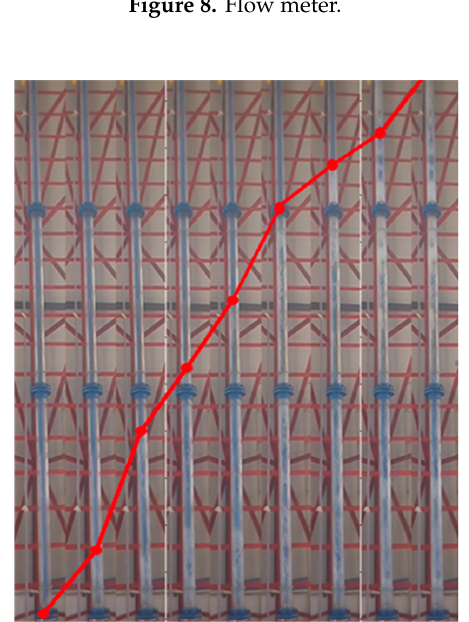
Figure 8. Flow meter.